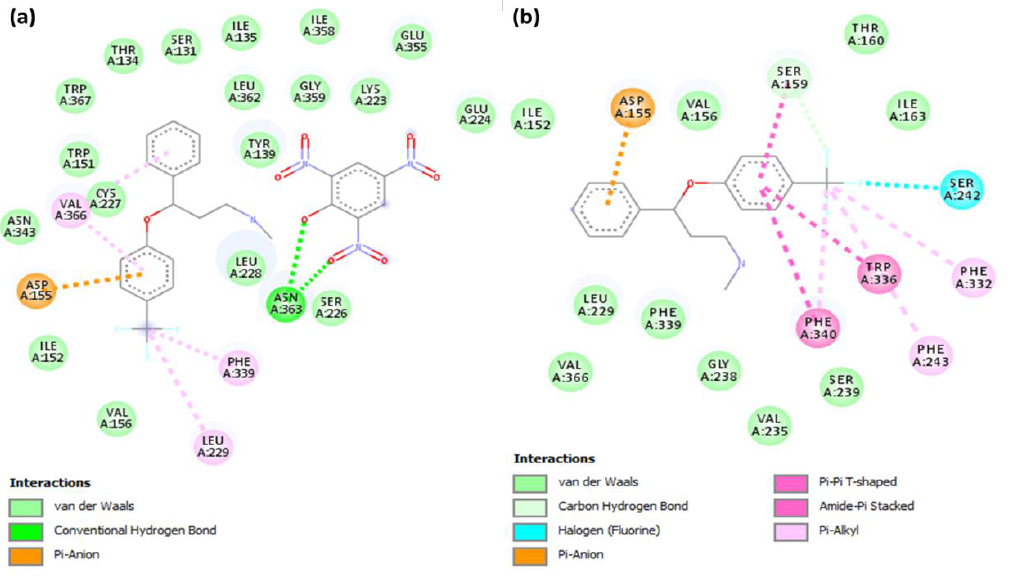
Figure 7. Two-dimensional illustration of interactions of ( a ) [(FXN)(PA)] – serotonin or ( b ) (FXN) – serotonin.